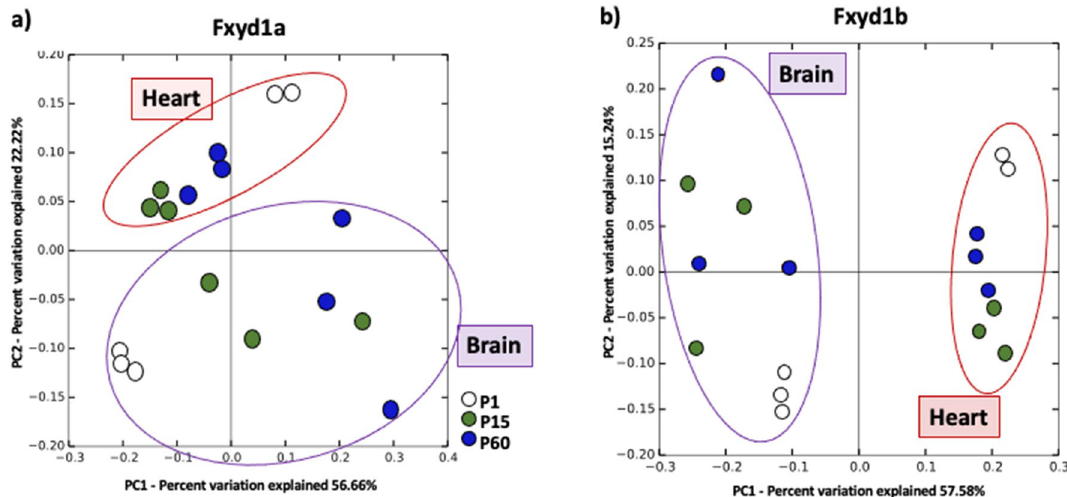
Figure 7. Epialleles distribution of Fxyd1a and Fxyd1b genes in brain and heart performed by PCA. Red and purple circles represent sample clusters based on epiallele distribution in heart and brain, respectively, considering all developmental stages. ( a ) Epialleles distribution analysis of Fxyd1a gene applied on both analyzed tissues pulling together all the developmental stages. ( b ) Epialleles distribution analysis of Fxyd1b promoter applied on both tissues analyzed considering all the developmental